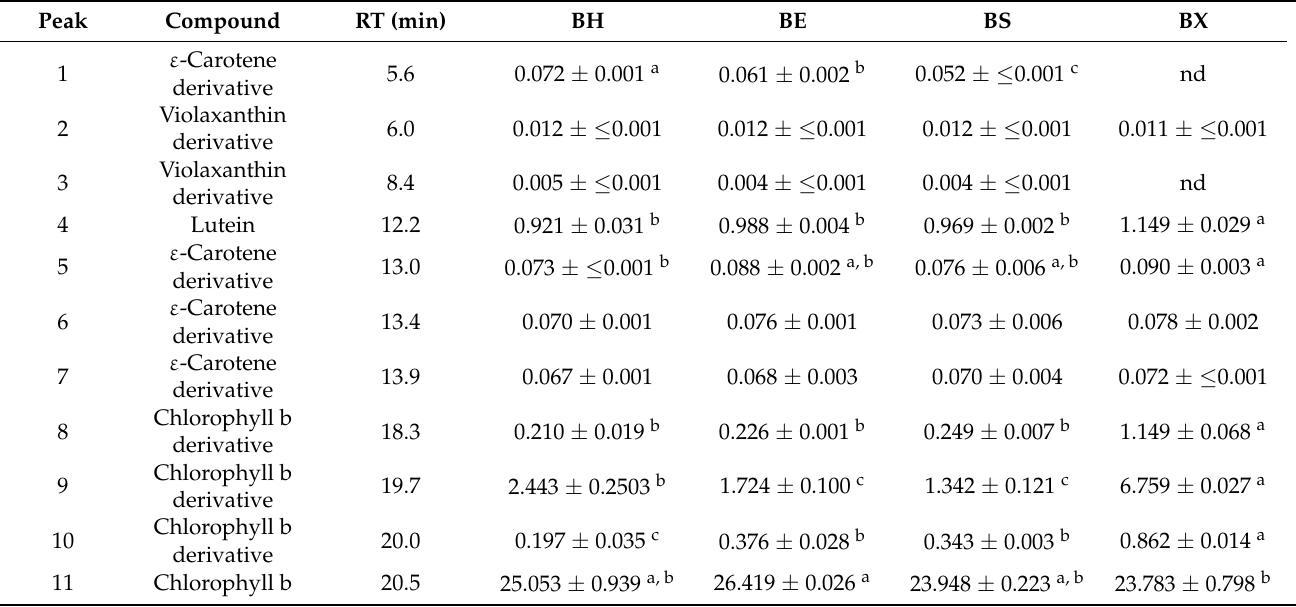
Table 4. Carotenoid and Chlorophyll content ( µ g/mg dry extract) of methanol extracts of B. monnieri obtained from different environments in Mexico determined using HPLC-PDA 1